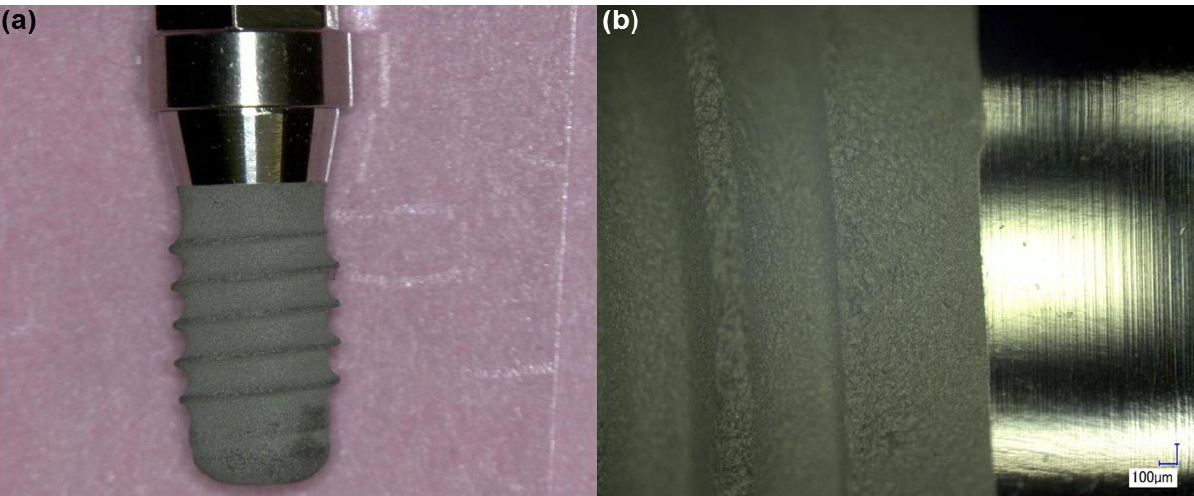
Figure 1. Control implant. ( a ) Low magnification overview of the surface of the implant; and ( b ) higher magnification showing surface condition of the smooth and rough interfaces of the